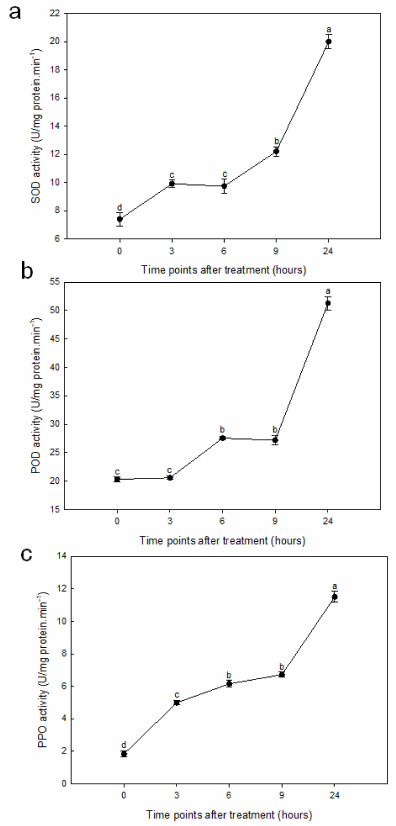
Figure 2. Antioxidative enzyme ( a ) superoxide dismutase (SOD); ( b ) peroxidase (POD); and ( c ) polyphenol oxidase (PPO) activity of sorghum root in response to PEG simulated drought stress (two-week-old seedlings treated with 10% PEG-6000). Data are presented as mean ± SD ( n = 3). Di ff erent letters indicate statistically significant di ff erences at p <